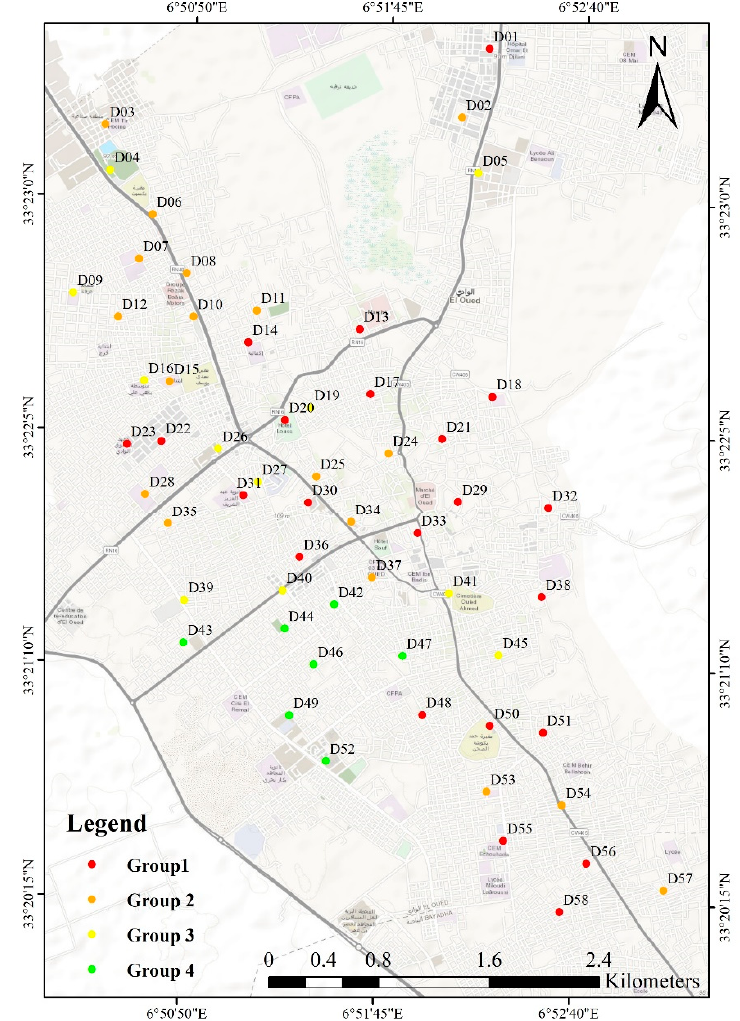
Figure 6. Map showing four clusters of